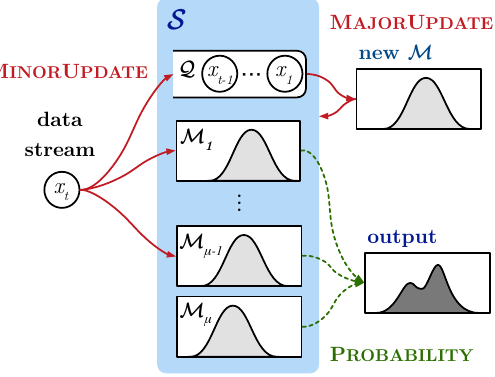
Figure 1. Overview of the proposed FlexSketch